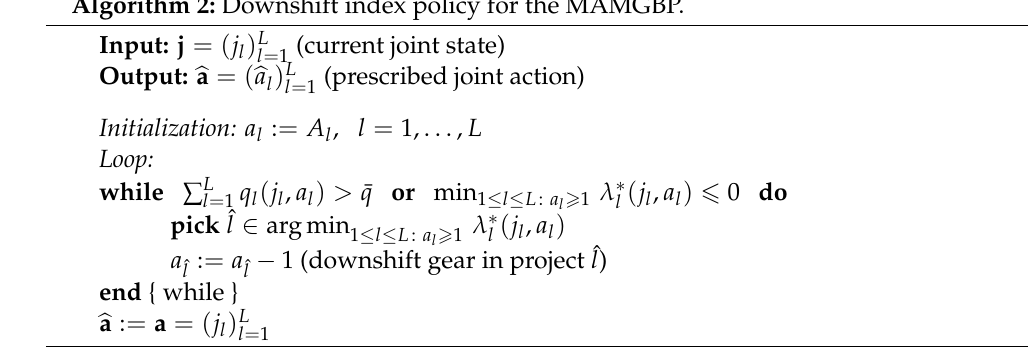
Algorithm 2: Downshift index policy for the